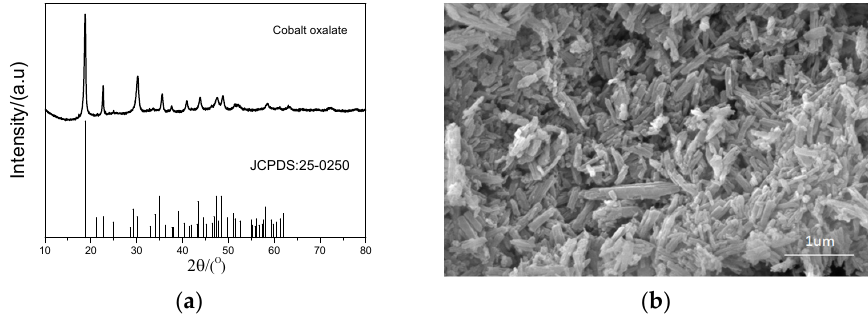
Figure 14. Characteristics of Co precipitate: ( a ) XRD pattern and ( b ) SEM image. After extraction by a P507–N235 system under the optimal conditions, the raffinate contained Ni and Li. The addition of oxalic acid into the raffinate led to the formation of precipitate with the precipitation efficiency of 99%. XRD and SEM were used to analyze the alate with the granular morphology.